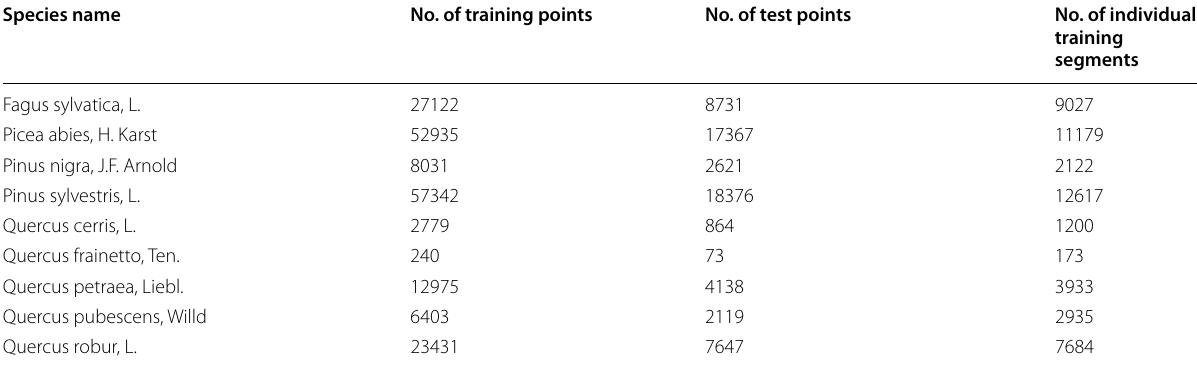
Table 7 The number of training points, test points, and training segments by species